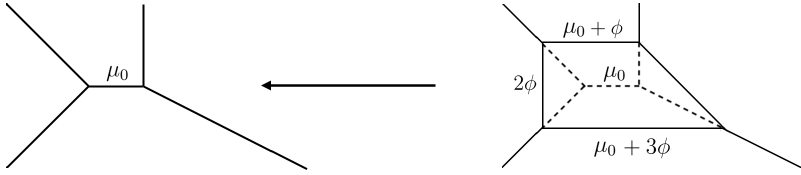
Figure 4 . F1 theory with positive bare coupling-squared ( µ 0 > 0 ).